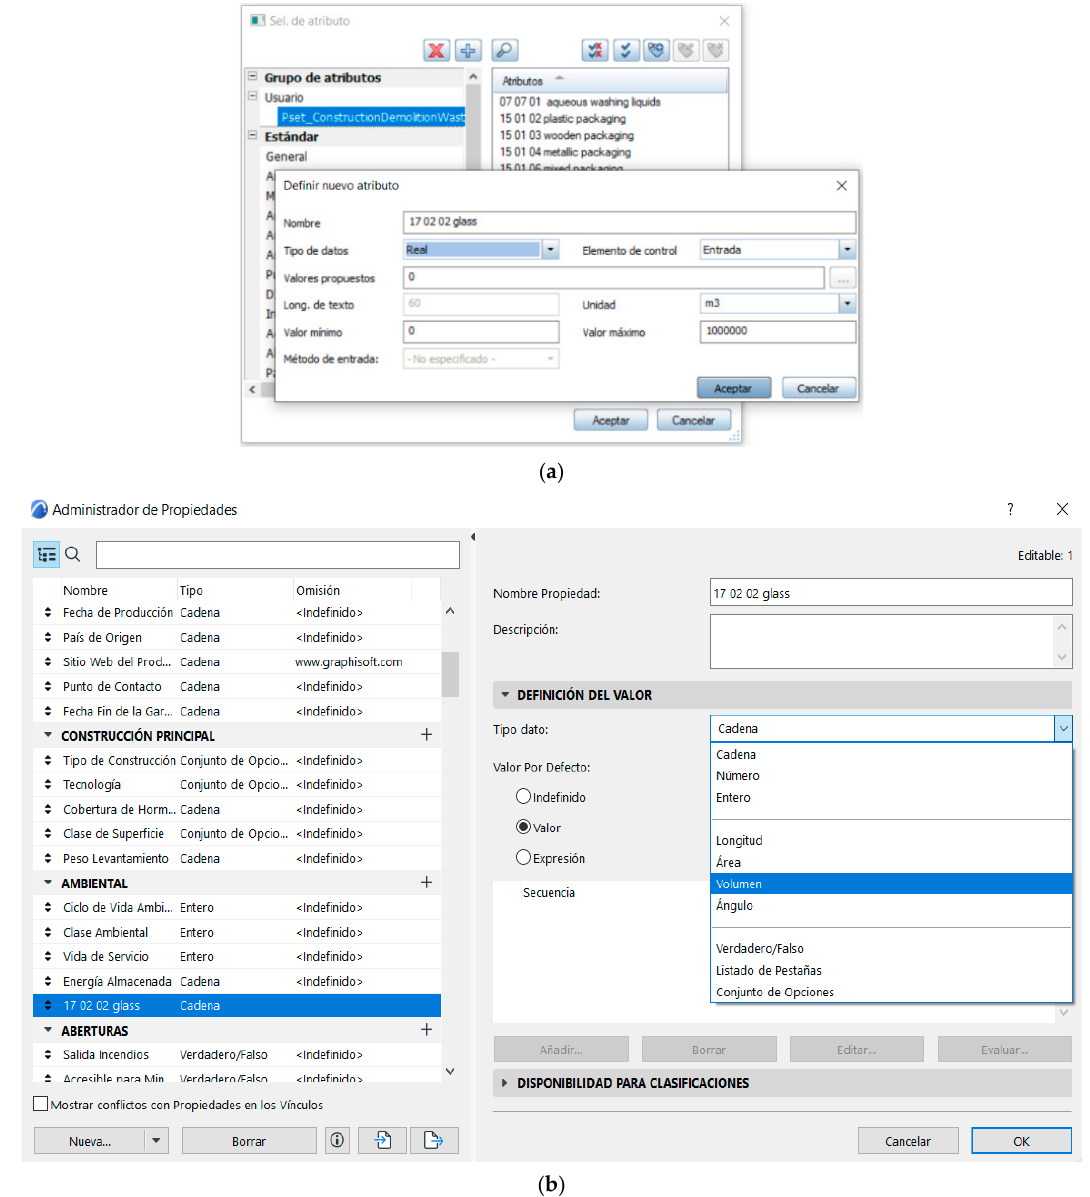
Figure 2. Panel for the definition of attributes and type of parameters: ( a ) Allplan; ( b ) Archicad. Creating CW Attributes in Archicad